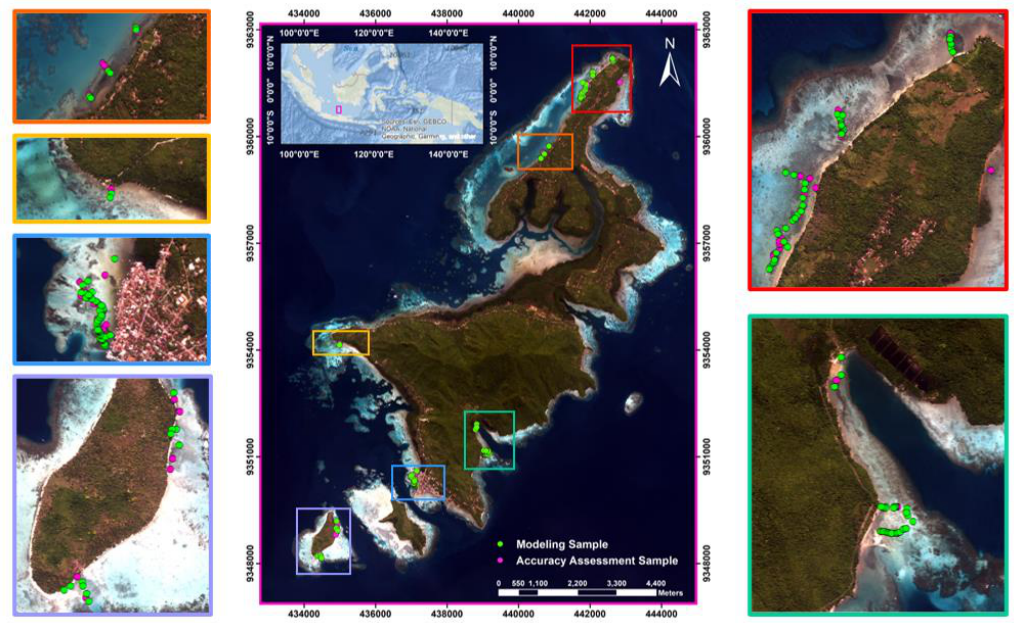
Figure 1 . Satellite images of the study area and the spatial distribution of seagrass